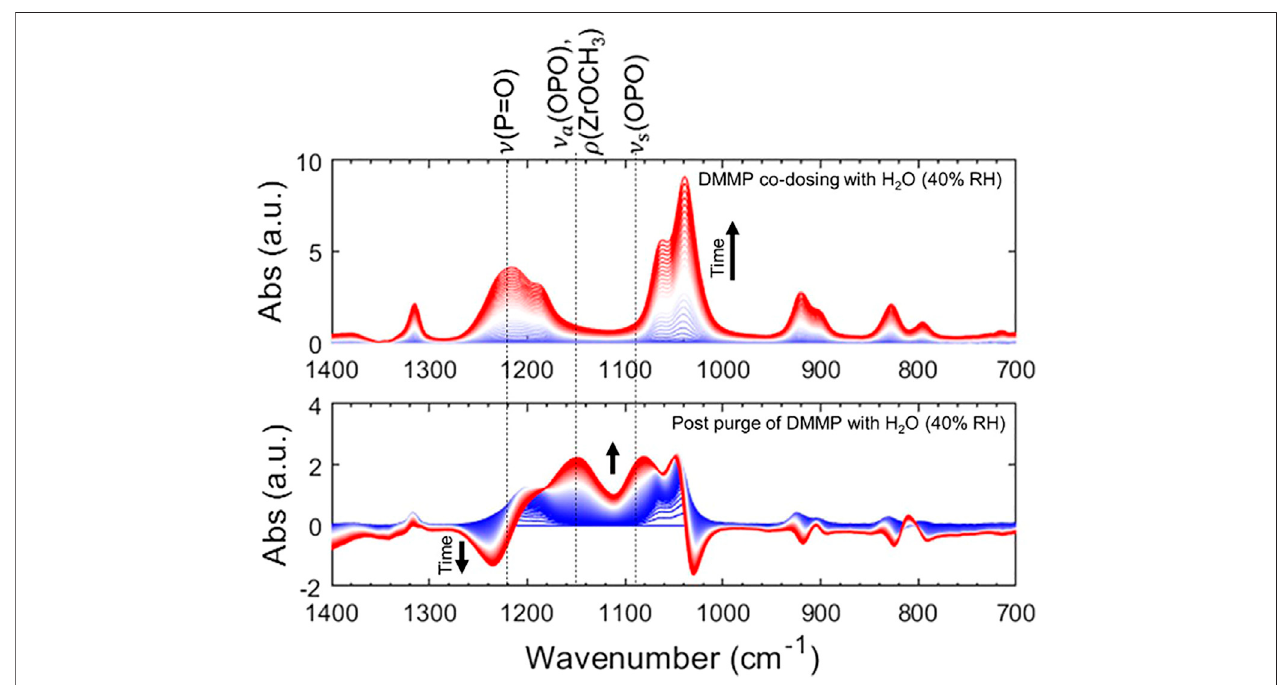
FIGURE7| Time-resolvedattenuatedtotalre fl ection – infraredspectroscopy(ATR-IR)ofZrO x H y aerogelsunderDMMPdosing (top) andDMMPremoval (bottom) . Adapted from Long et al. (2020) with permission from the American Chemical Society.